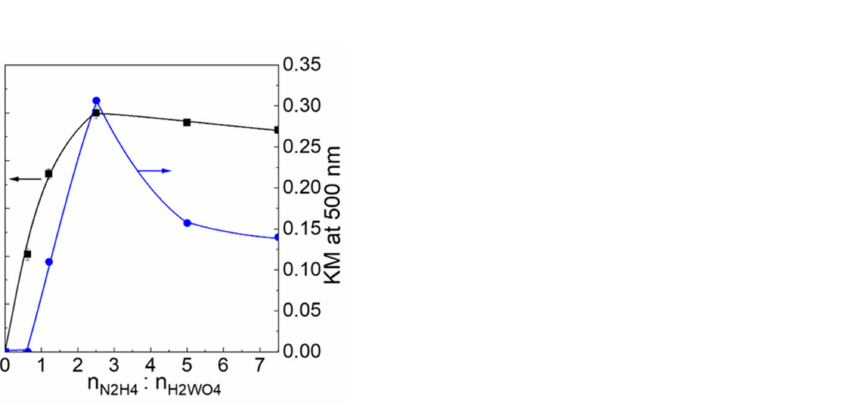
Figure 7. Relationship between the relative contents of N and n H2WO4 :n N2H4 ratio. The relative N contents were measured in EDS data and normalized by the highest contents for n H2WO4 :n N2H4 of 1:2.5.